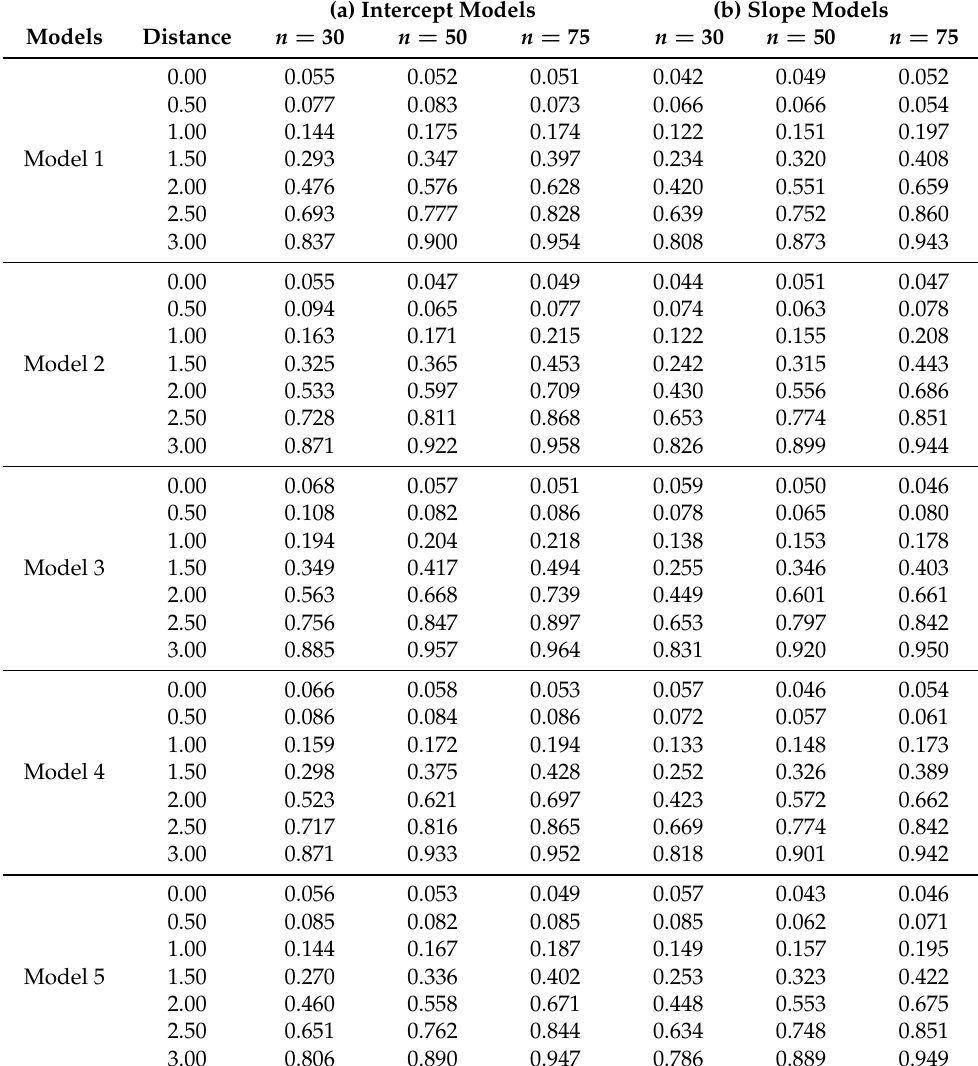
( τ ) for intercept models and slope models with τ = 0.25. hs (a) Intercept Models (b) Slope